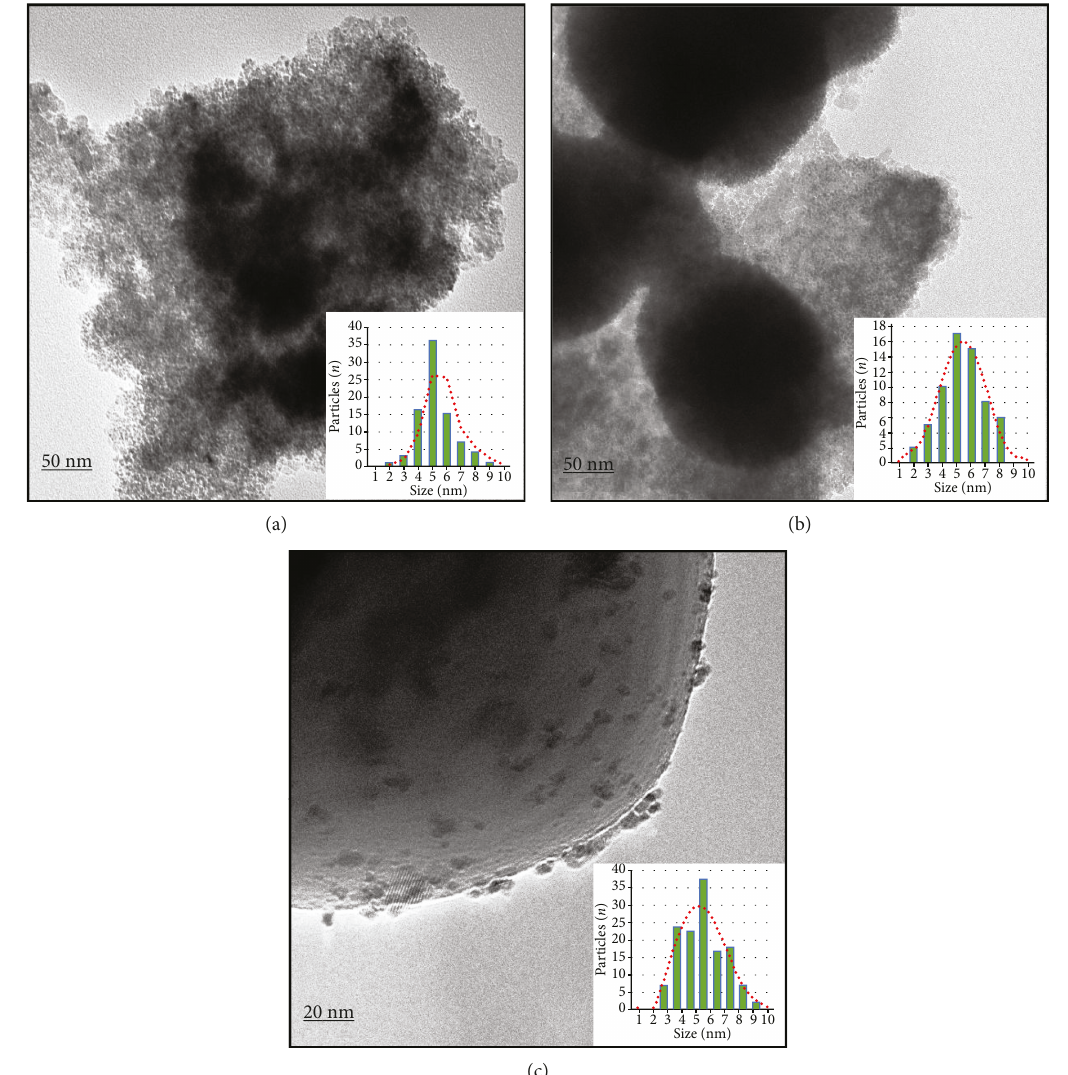
Figure 2: (a, b, c) TEM images of 100%Ru, 10%TiO